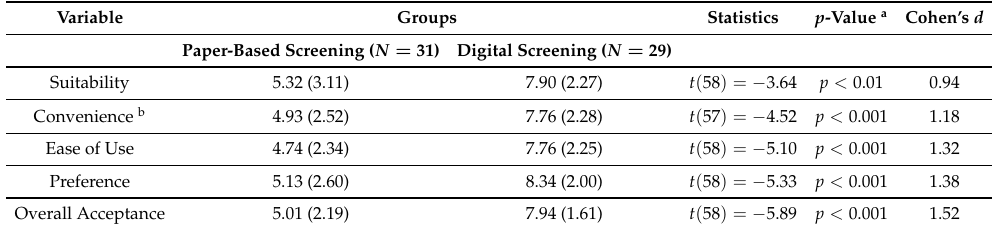
Table 3. Group comparision of acceptance between using a digital screening (FeelBack application) and a traditional paper-based screening.